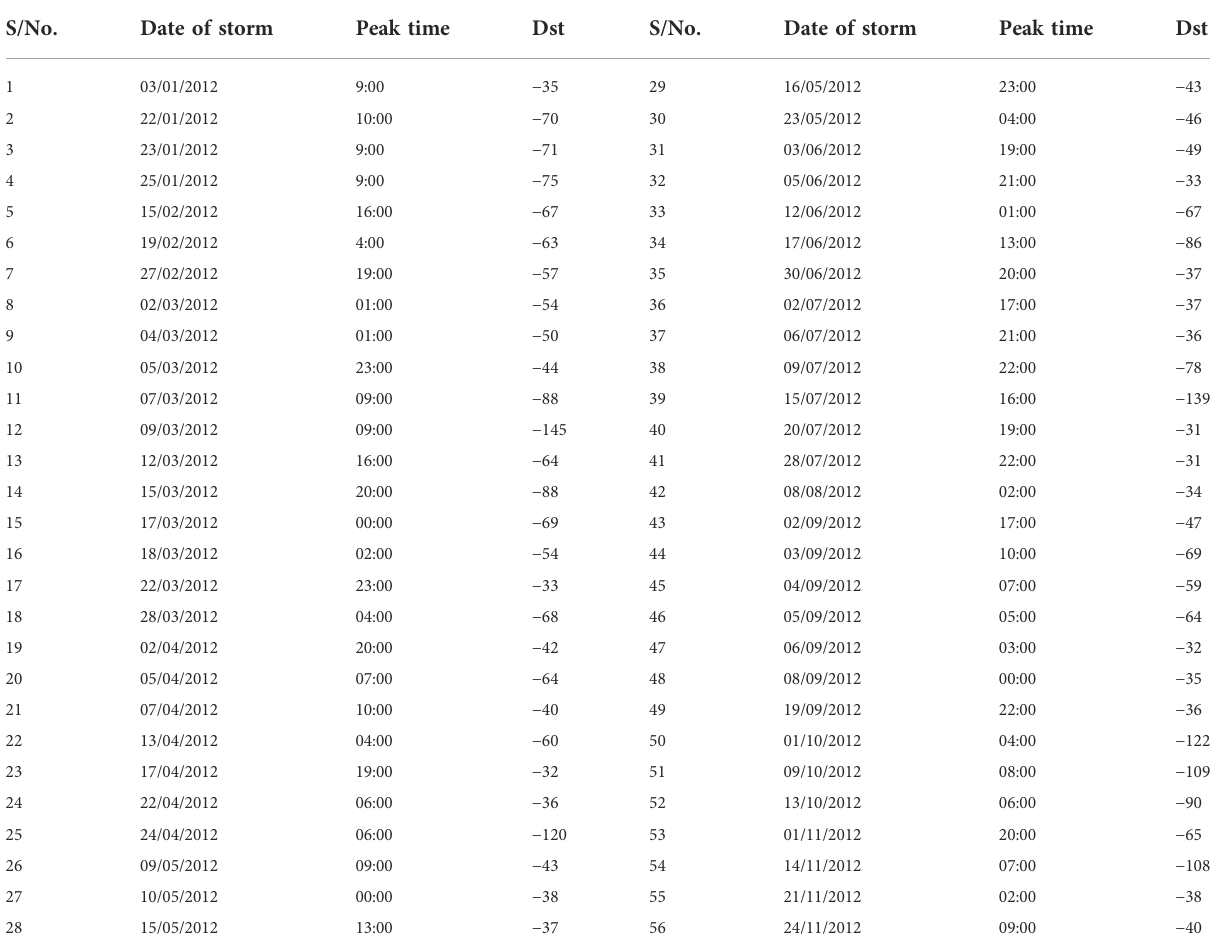
TABLE 4 Days of geomagnetic storm peaks in the year 2012, with Dst < − 30 nT.